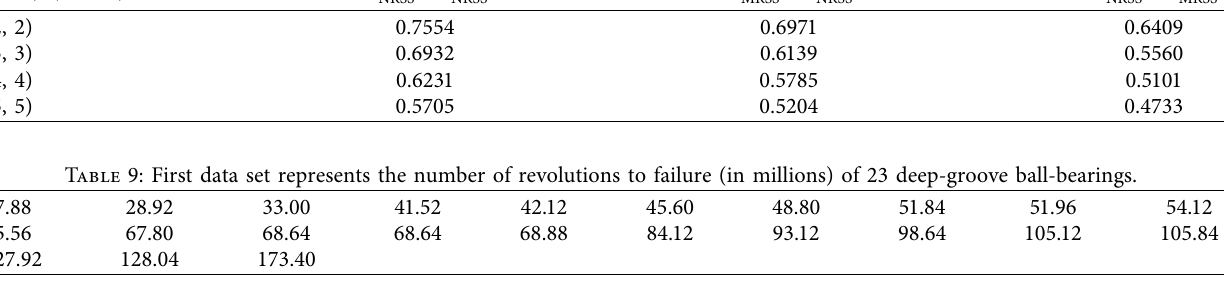
Table 10: Second data set represents 30 failure times of the air conditioning system of an airplane (in hours). 23 261